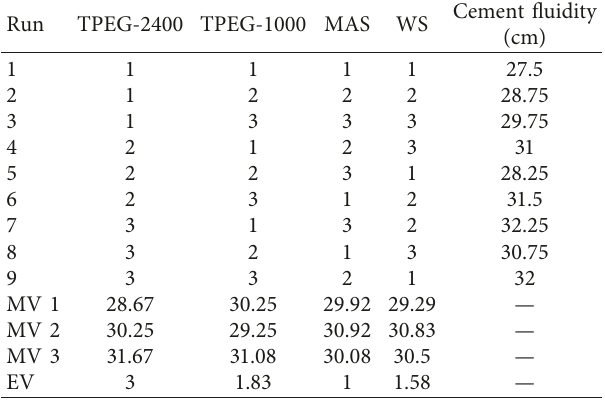
Table 1: Orthogonal experimental design for nine trials with three levels of concentrations for each reactant components’ variable and corresponding cement fluidity.